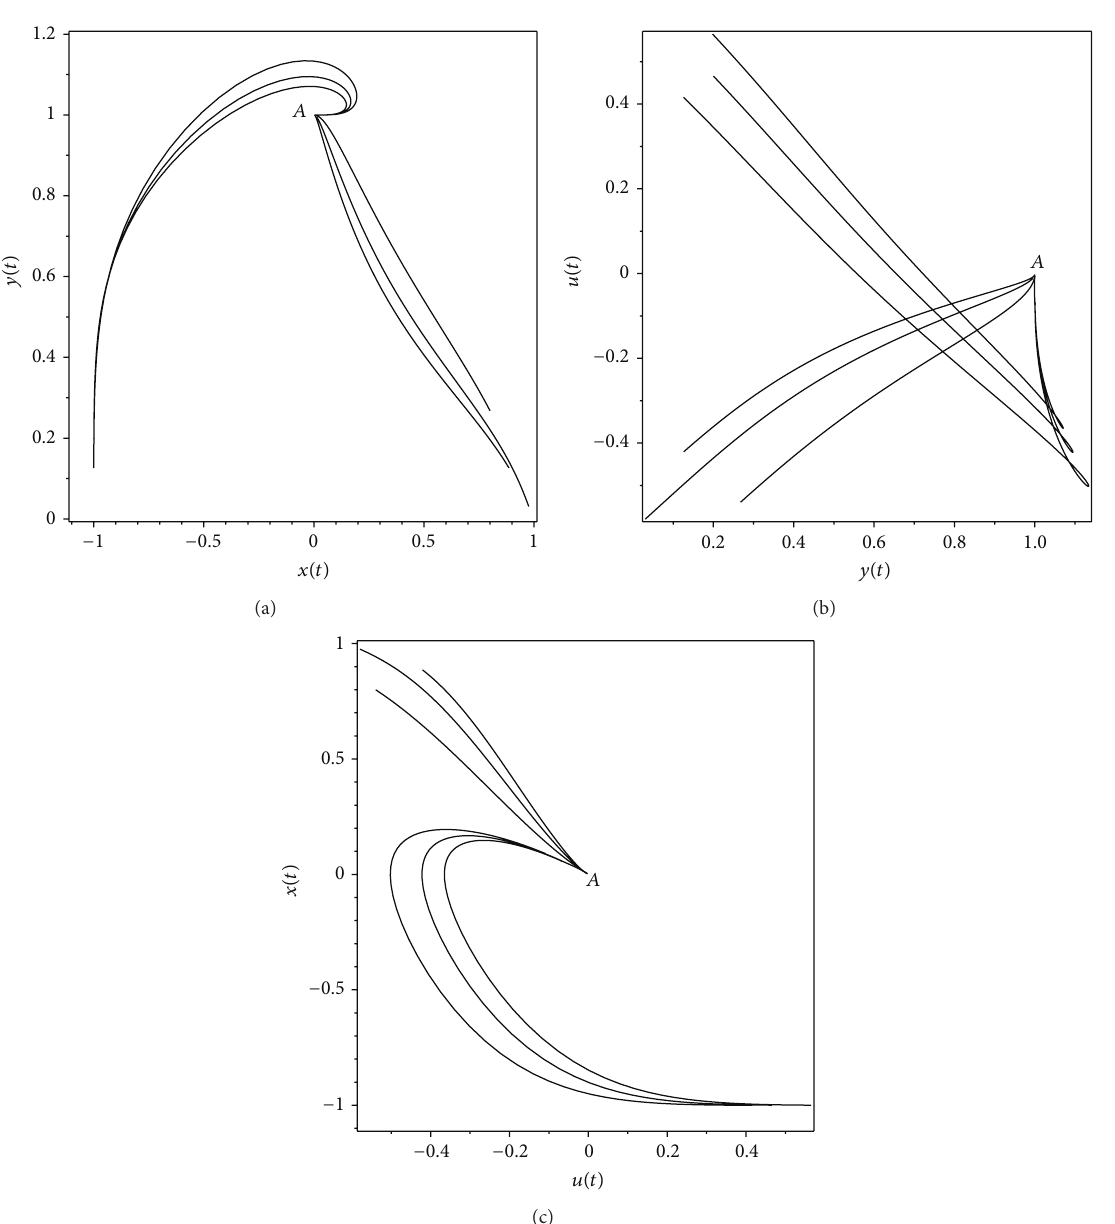
Figure 1: From (a) to (c), the projections of the phase-space trajectories on the 𝑦 − 𝑥 , 𝑢 − 𝑦 , and 𝑥 − 𝑢 planes with 𝜉 = 0.5 and 𝛼 = 1.5 . For these values of the parameters, point 𝐴 is a stable